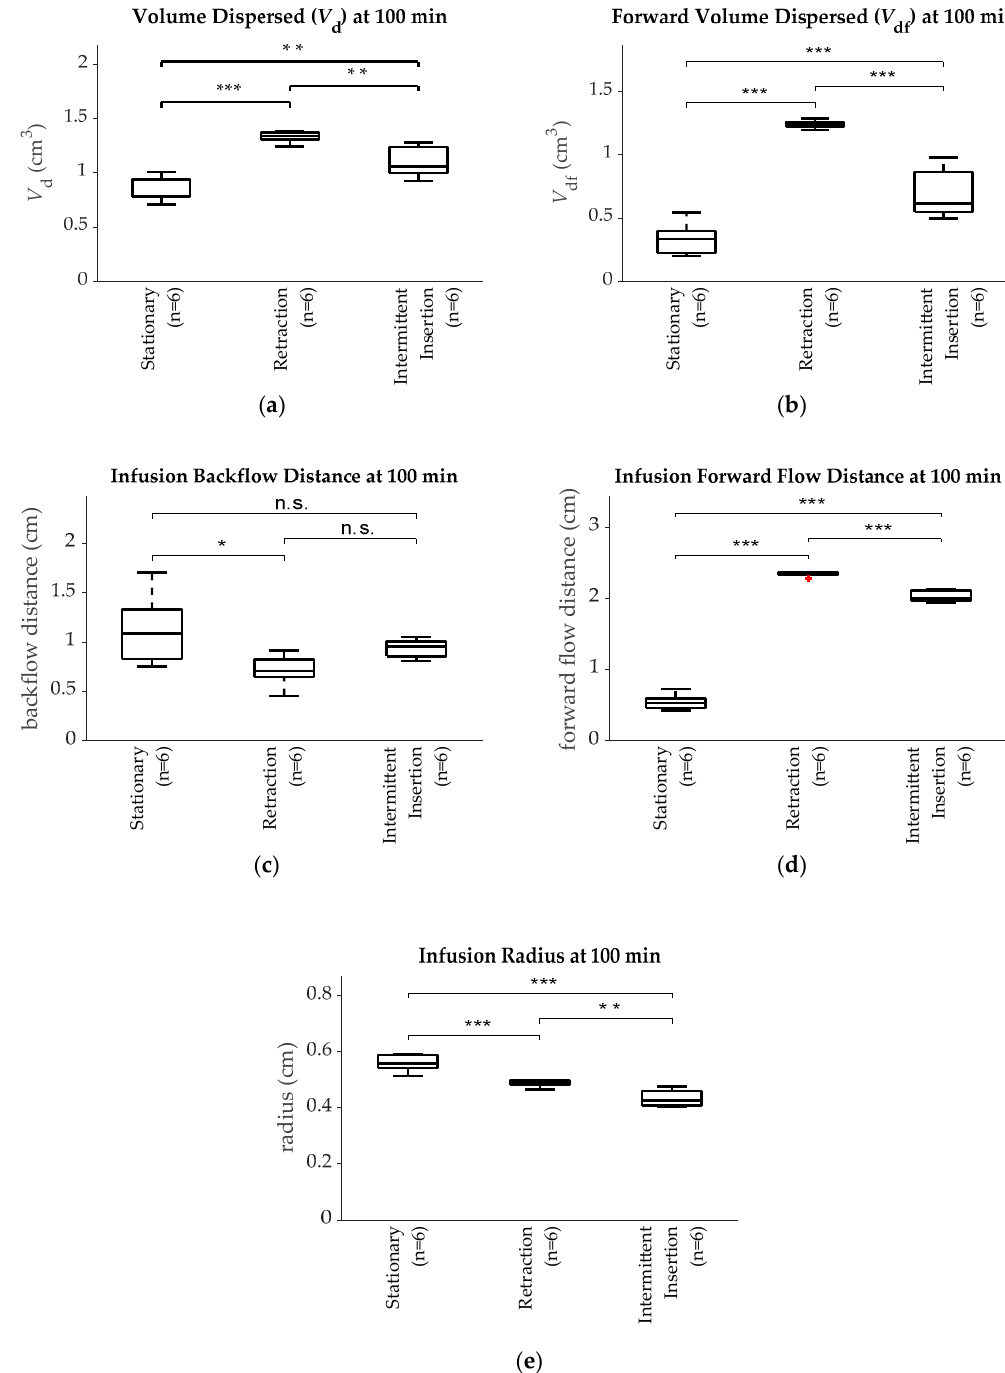
Figure 3. Plots of the ( a ) total volume dispersed ( V d ); ( b ) forward volume dispersed ( V df ); ( c ) backflow distance; ( d ) forward flow distance; and ( e ) infusion radius for the stationary, retraction, and intermittent insertion groups after 100 min of infusion. Note: * p ≤ 0.05; ** p ≤ 0.01; *** p ≤ 0.001 Data over infusion time: Figure 4 shows the outcome measurements at 20-min intervals through the 100-min infusion for each group. The retracting group had a higher V d than either the stationary or intermittent insertion groups for all calculated time points, with significant levels ( p < 0.01) of V d at all time points after 20 min. The intermittent insertion group had a significantly higher V d than the